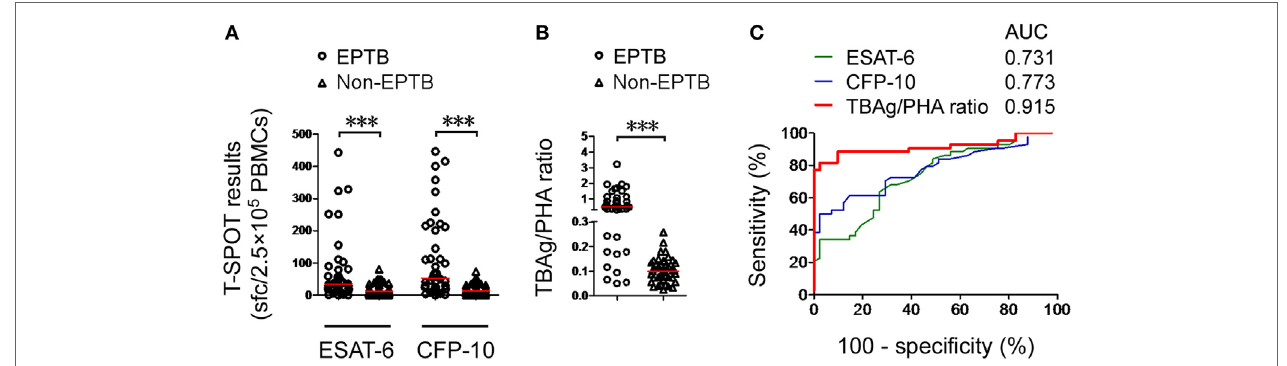
FigUre 3 | Validation of the TBAg/PHA ratio. (a) Dot plots showing ESAT-6 sfc, CFP-10 sfc, and (B) the TBAg/PHA ratio in T-SPOT positive validation patients with EPTB ( n = 44) and non-EPTB ( n = 41). Bars indicate medians (*** p < 0.001). (c) Receiver operating characteristic analysis was performed for ESAT-6 sfc, CFP-10 sfc, and the TBAg/PHA ratio in distinguishing EPTB from non-EPTB. Abbreviations: EPTB, extrapulmonary tuberculosis; ESAT-6, early secreted antigenic target 6; CFP-10, culture filtrate protein 10; AUC, area under the curve; TBAg, TB-specific antigen; PHA, phytohemagglutinin; sfc, spot-forming cells.